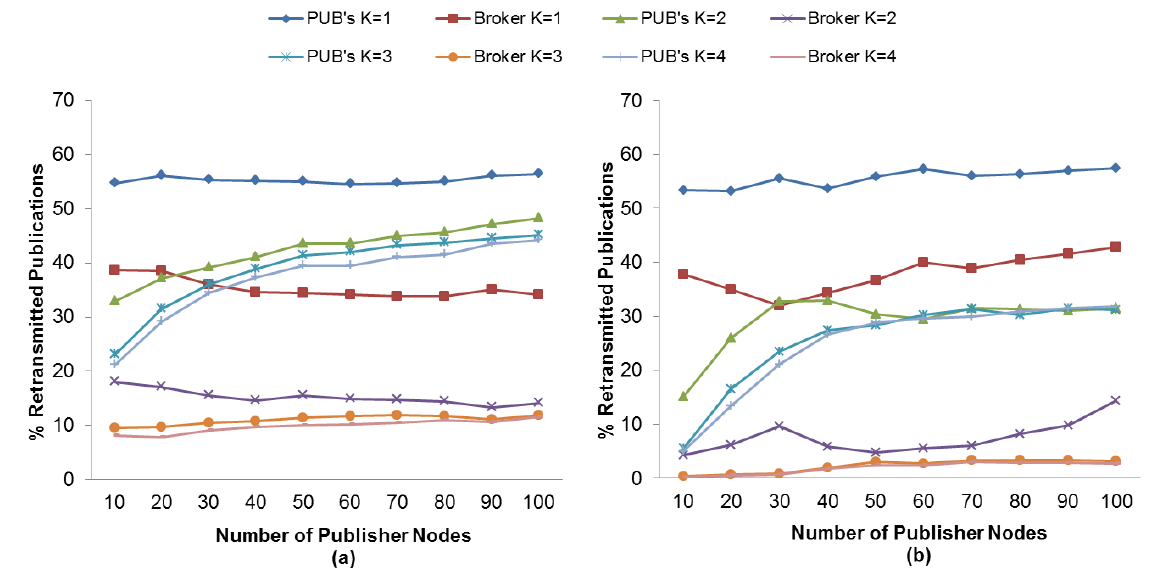
Figure 12. Effect of the number of Publisher nodes on publication messages retransmitted from Broker and Publisher Nodes using different K values without ( a ) and with ( b ) MAC